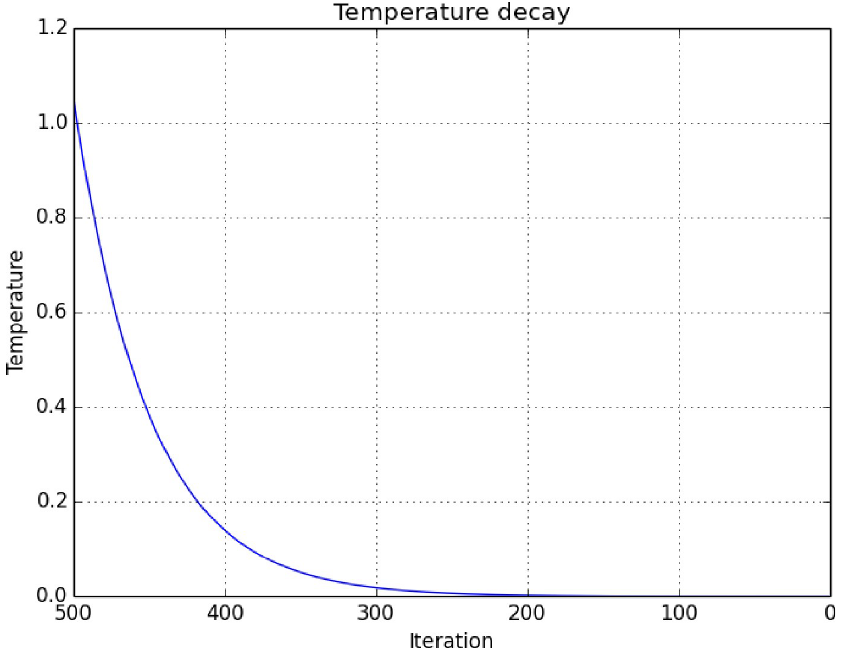
Fig 8. Temperature decay relative to the iterations of the SA